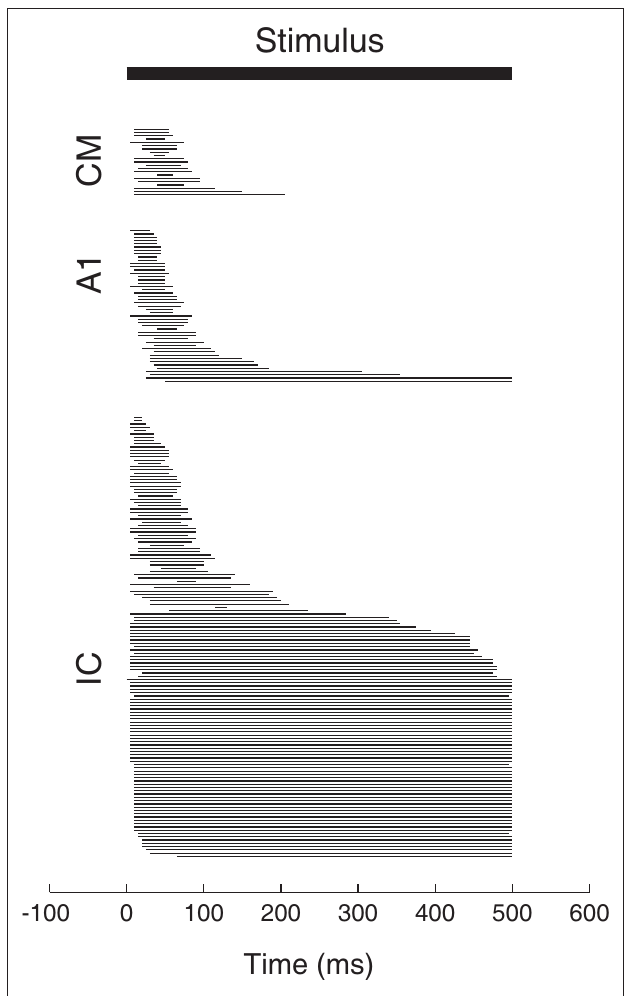
FIgure 2 | Stimulus period spike-counting windows for the neurons in the present dataset. Each bar represents the period of time detected as the excitatory response period during sound presentation for a neuron in our data set. Cells are sorted by the midpoint of this response period. The response periods of A1 and CM neurons tended to be very brief whereas some IC neurons showed sustained activity throughout the sound presentation.